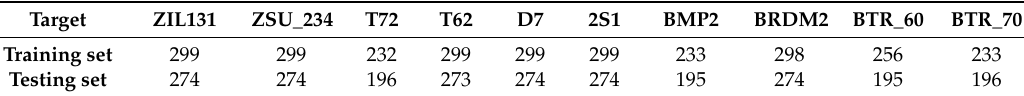
Table 3. Type and sample number of training and testing set.